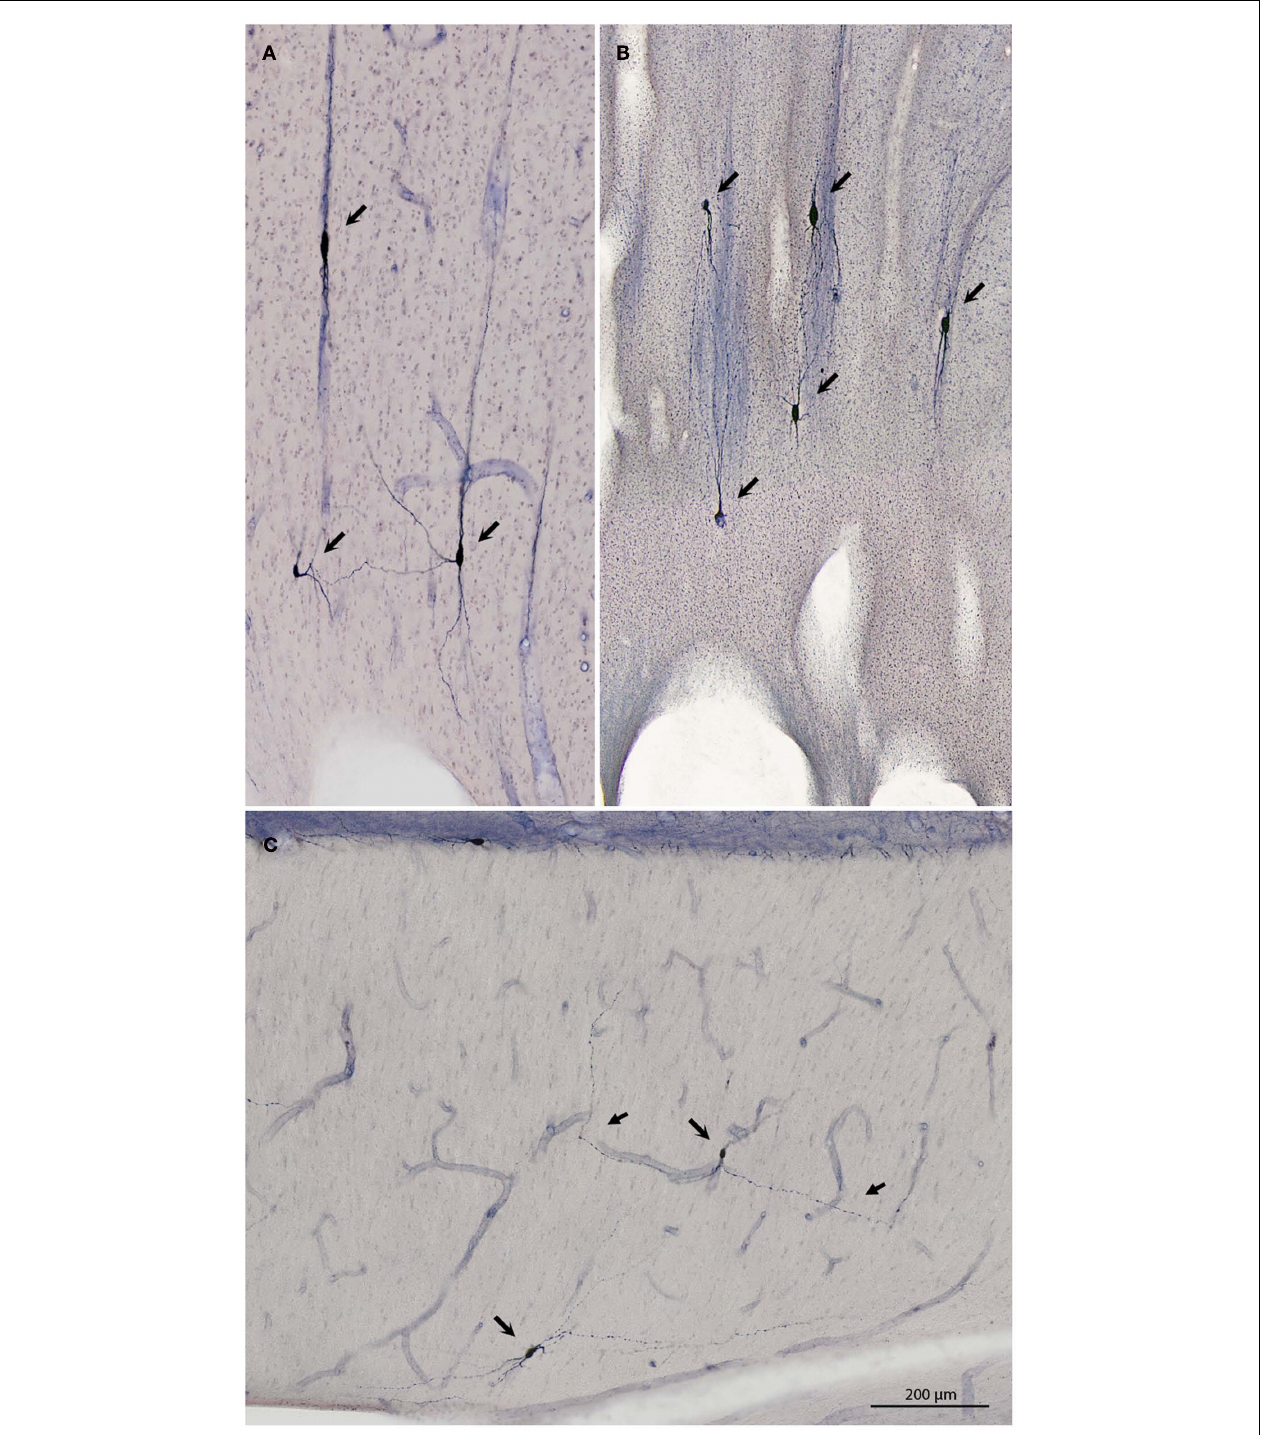
sake of formatting. (C) Two neurons (right pointing arrows) in the body of the callosum (case R31). Distal portions of the dendrite of the more dorsal neuron are indicated by left-pointing arrows.The left dendrite parallels one of the blood vessels for > 200 μ